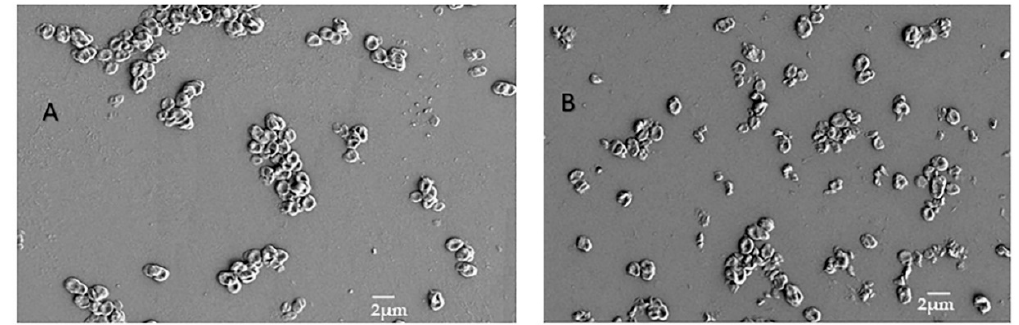
Figure 8. Showing SEM of MPI ( A ) and the MPIEDPCA conjugate ( B ) respectively.